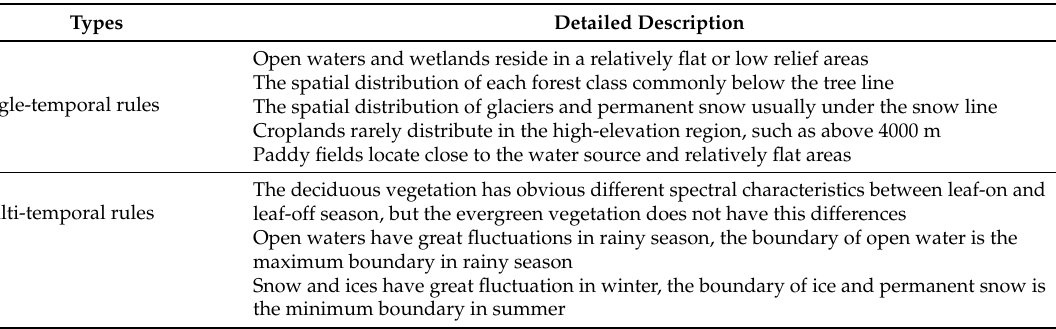
Table 3. The geographical rules used in the interactive quality